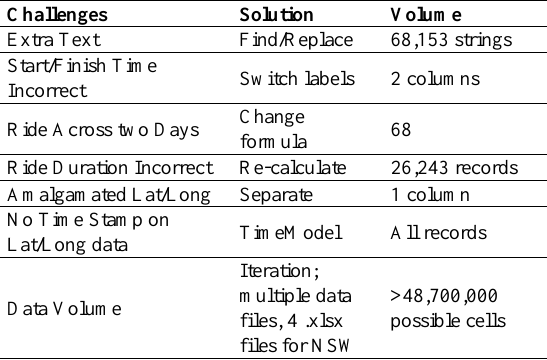
Table 1. Big Data Challenges, Solutions and Volume for the NSW Rider data